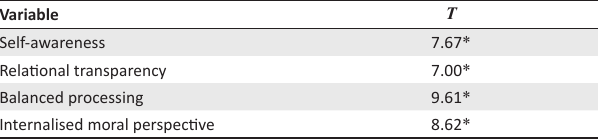
TABLE 5: Unstandardised gamma matrix. Variable